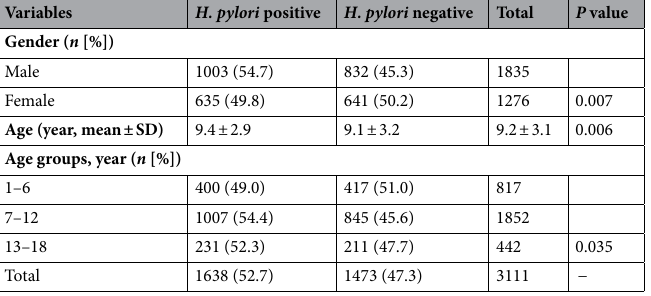
Table 1. Demographic characteristics and H. pylori culture of the 3111 subjects from 2015 to 2020.